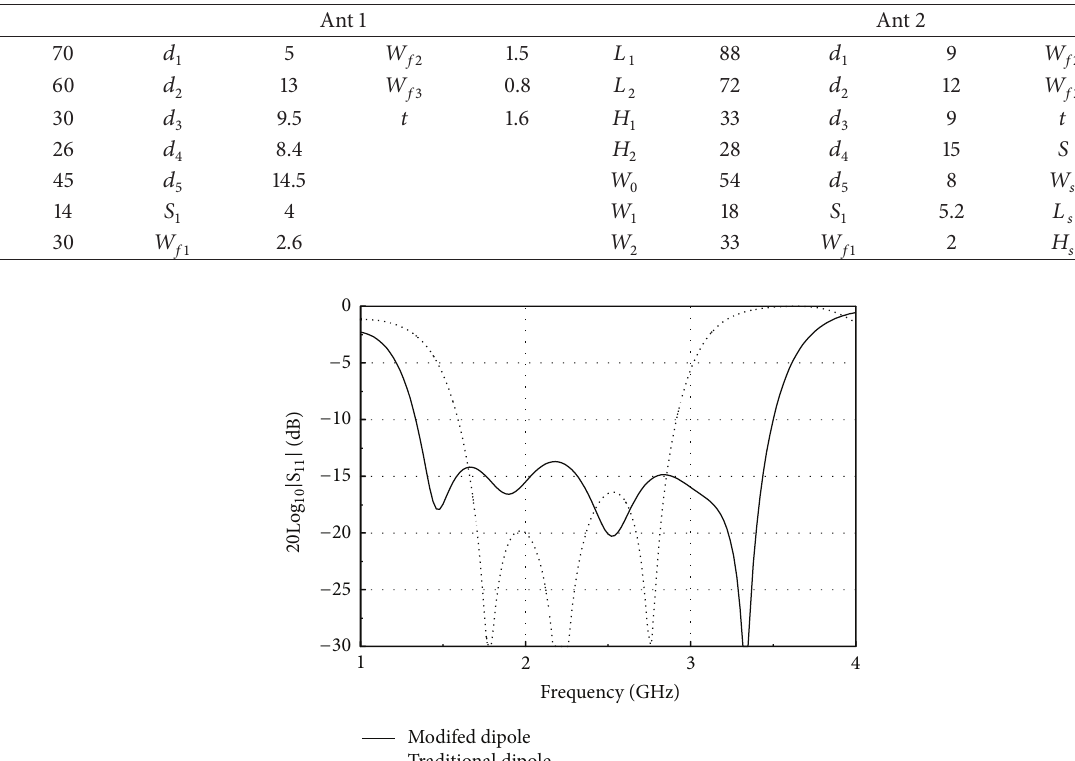
Table 1: Dimensions of the optimized traditional and proposed printed dipole antennas (unit: mm).